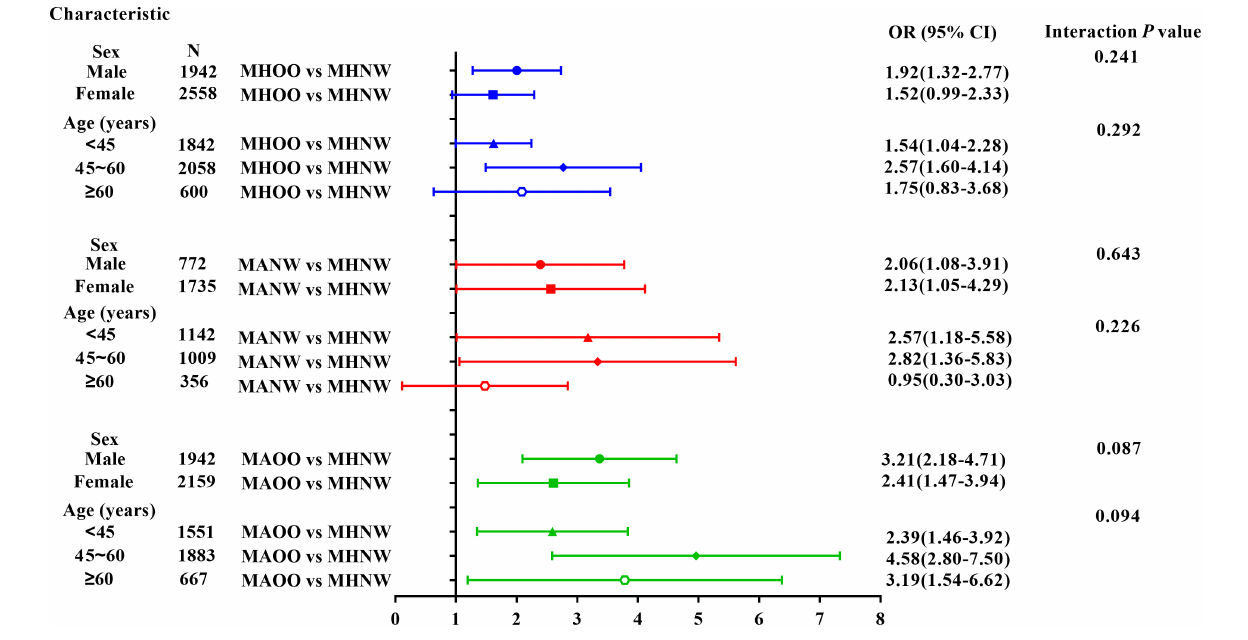
FIGURE 2 | Stratified analyses and interaction tests of the association between hyperuricemia and obesity phenotypes. Models are adjusted for HbA1c, TC, LDL-C, ALT, AST, TP, albumin, Cr, BUN. WBC, NEUT, EO, RBC, HGB, HCT, MCV, MCH, and